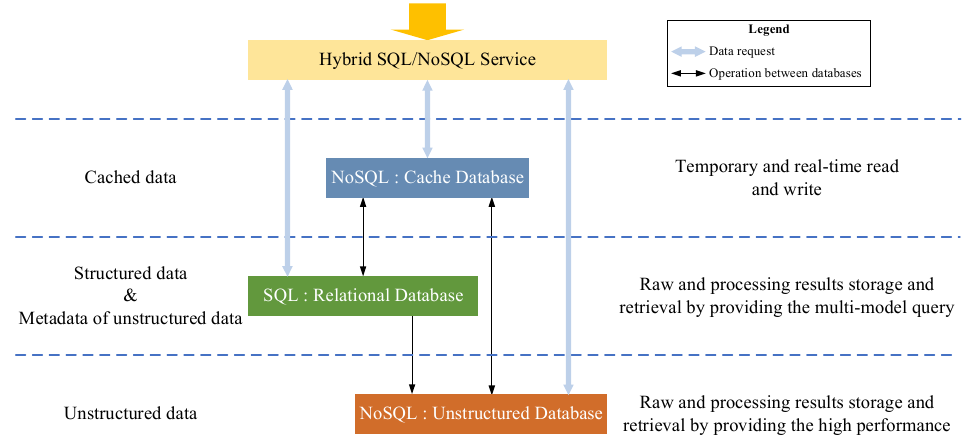
Figure 3. Hybrid storage architecture. Different types of databases store data for different structures and purposes. It should be noted that different types of NoSQL databases can be used to store different data. For example, Redis can be used as Cache Database , while MongoDB as Unstructured Database.